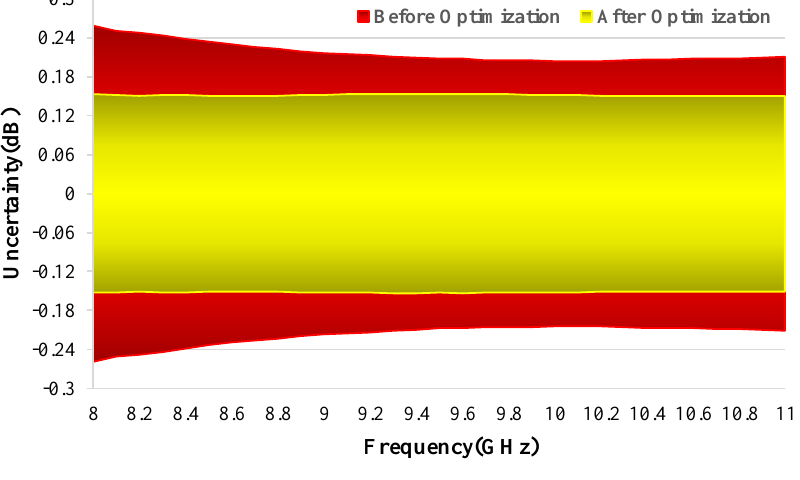
Figure 12. The test accuracy comparison. Table 5. NF measurement speed (in second).